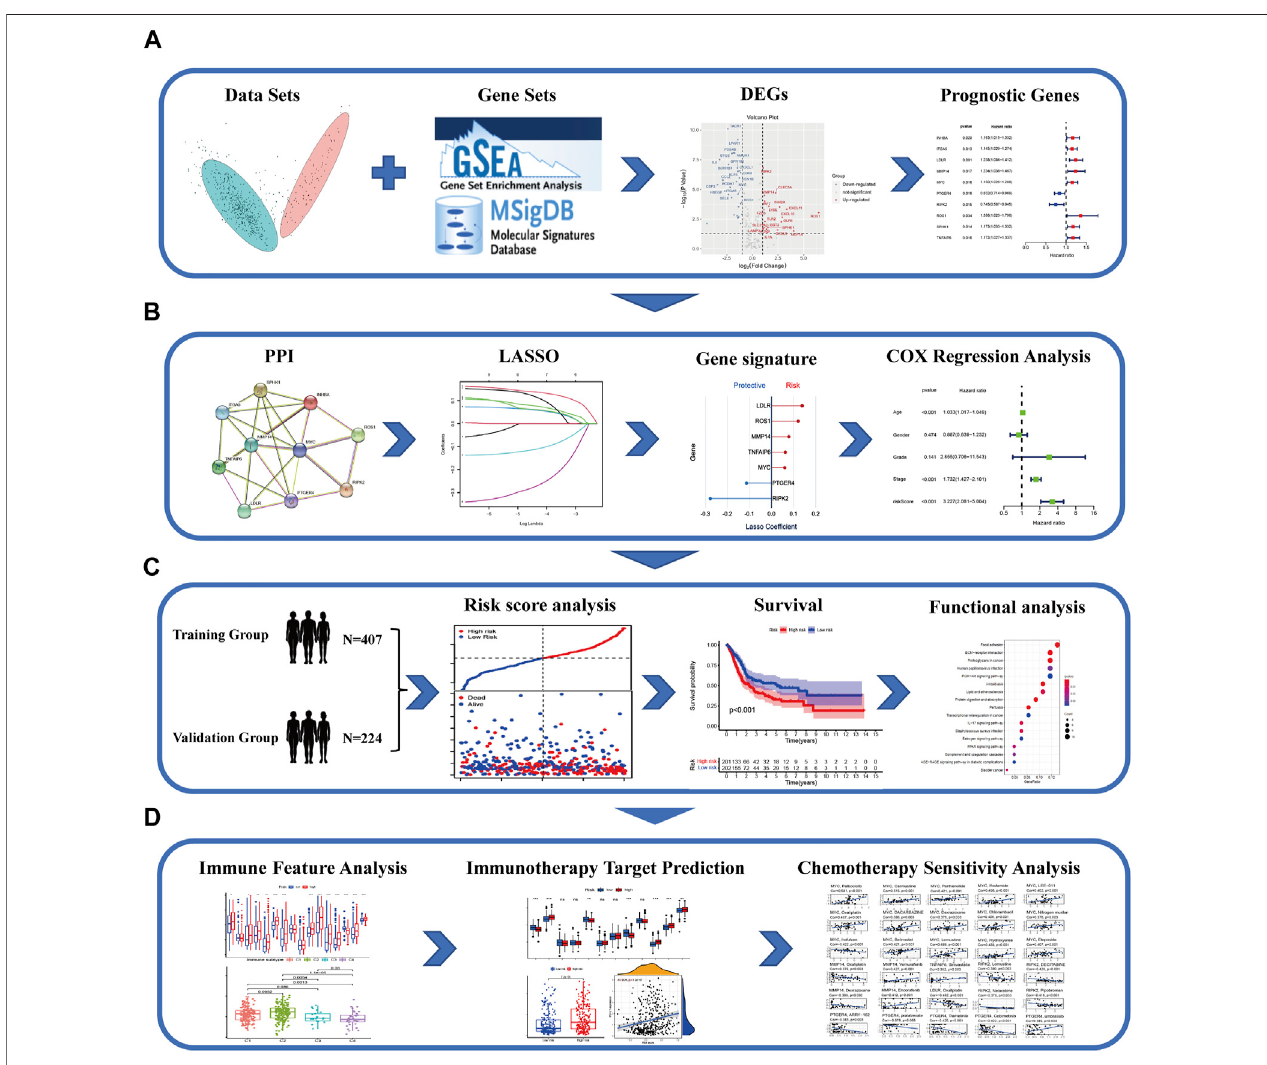
FIGURE 1 | Schematic chart of the research fl ow. (A) The in fl ammatory response – related DEGs between the tumor and normal tissues in TCGA – BLCA dataset. Prognostic signature was established by univariate cox regression analysis on the basis of the DEGs. (B) PPI network was constructed to illustrate the interaction of gene-related proteins. LASSO-penalty cox analysis was executed for an optimized prognostic signature. (C) Comprehensive methods to validate the forecast performanceoftheIRGsignatureinthemultipledatabases.Functionalenrichmentanalysisandsurvivalcurves. (D) TherelationshipbetweentheIRGsandimmune feature, immunotherapy target prediction, and chemotherapeutic drug sensitivity in patients with BLCA.